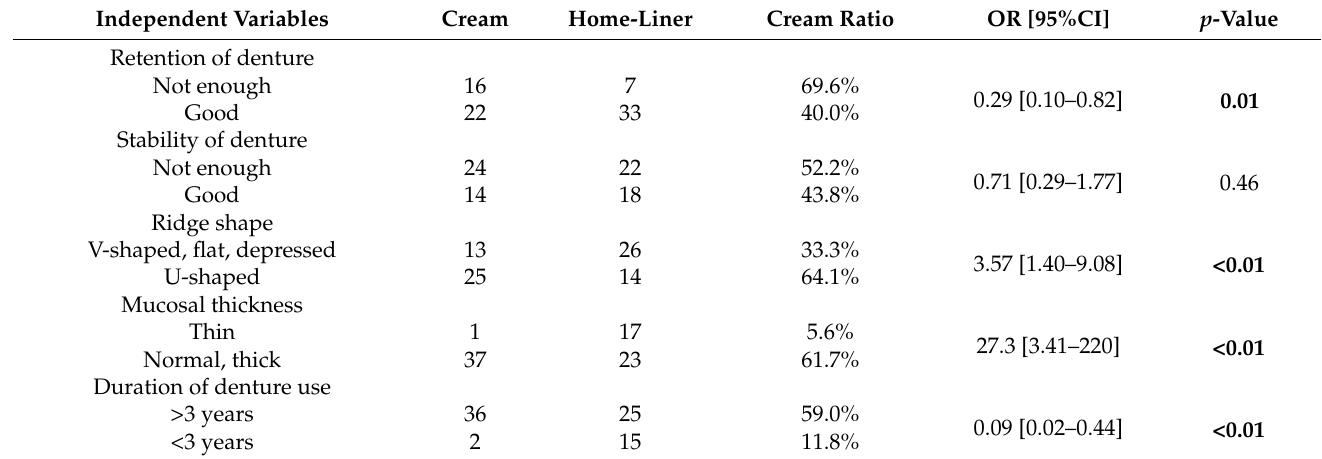
Table 3. Pearson’s chi-squared test with denture adhesive as a dependent variable.